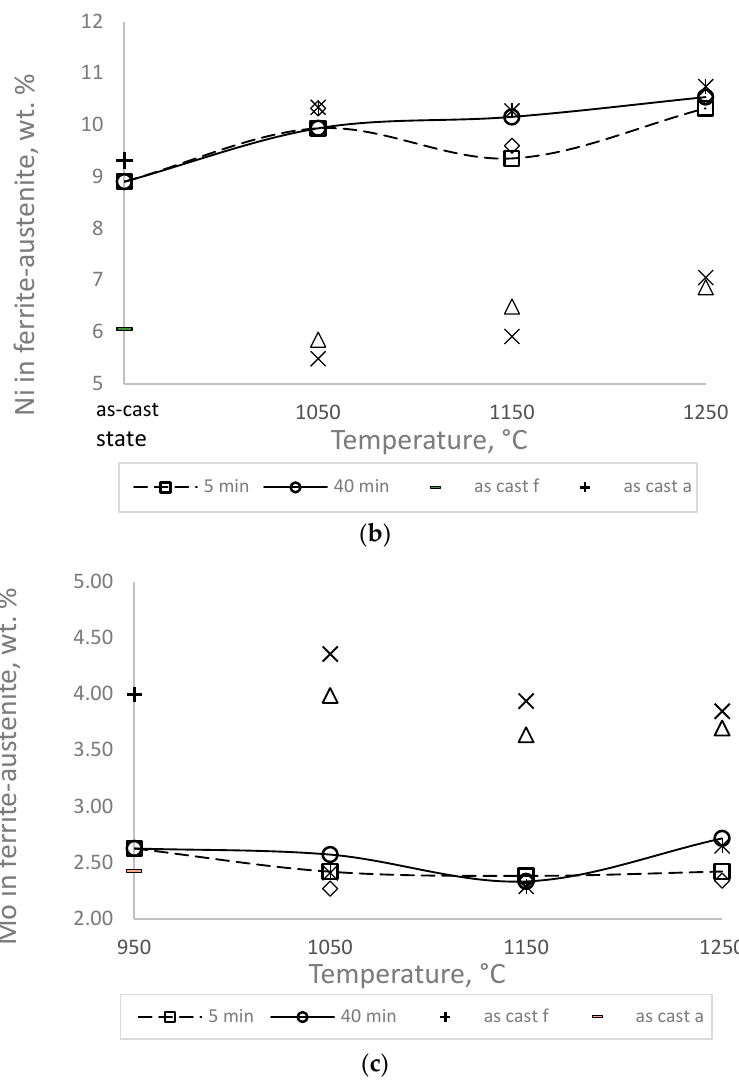
Figure 8. Distribution and cumulative concentrations of chromium ( a ), nickel ( b ) and molybdenum ( c ) in the δ -ferrite - f - and austenite - a after annealing for 5 or 40 min; concentration markers: Δ 5 min f, × 40 min f, ◊ 5 min a, ∗ 40 min a.